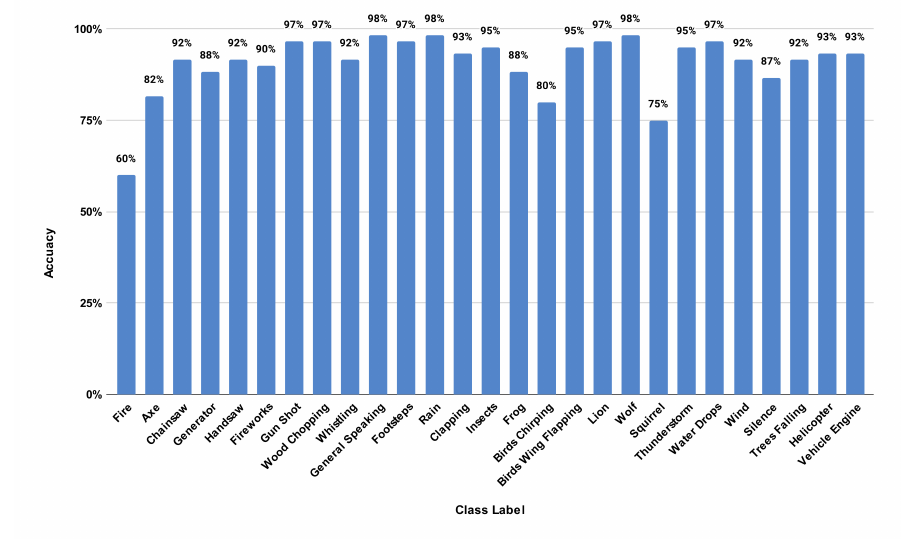
Figure 10. Class accuracies obtained in human